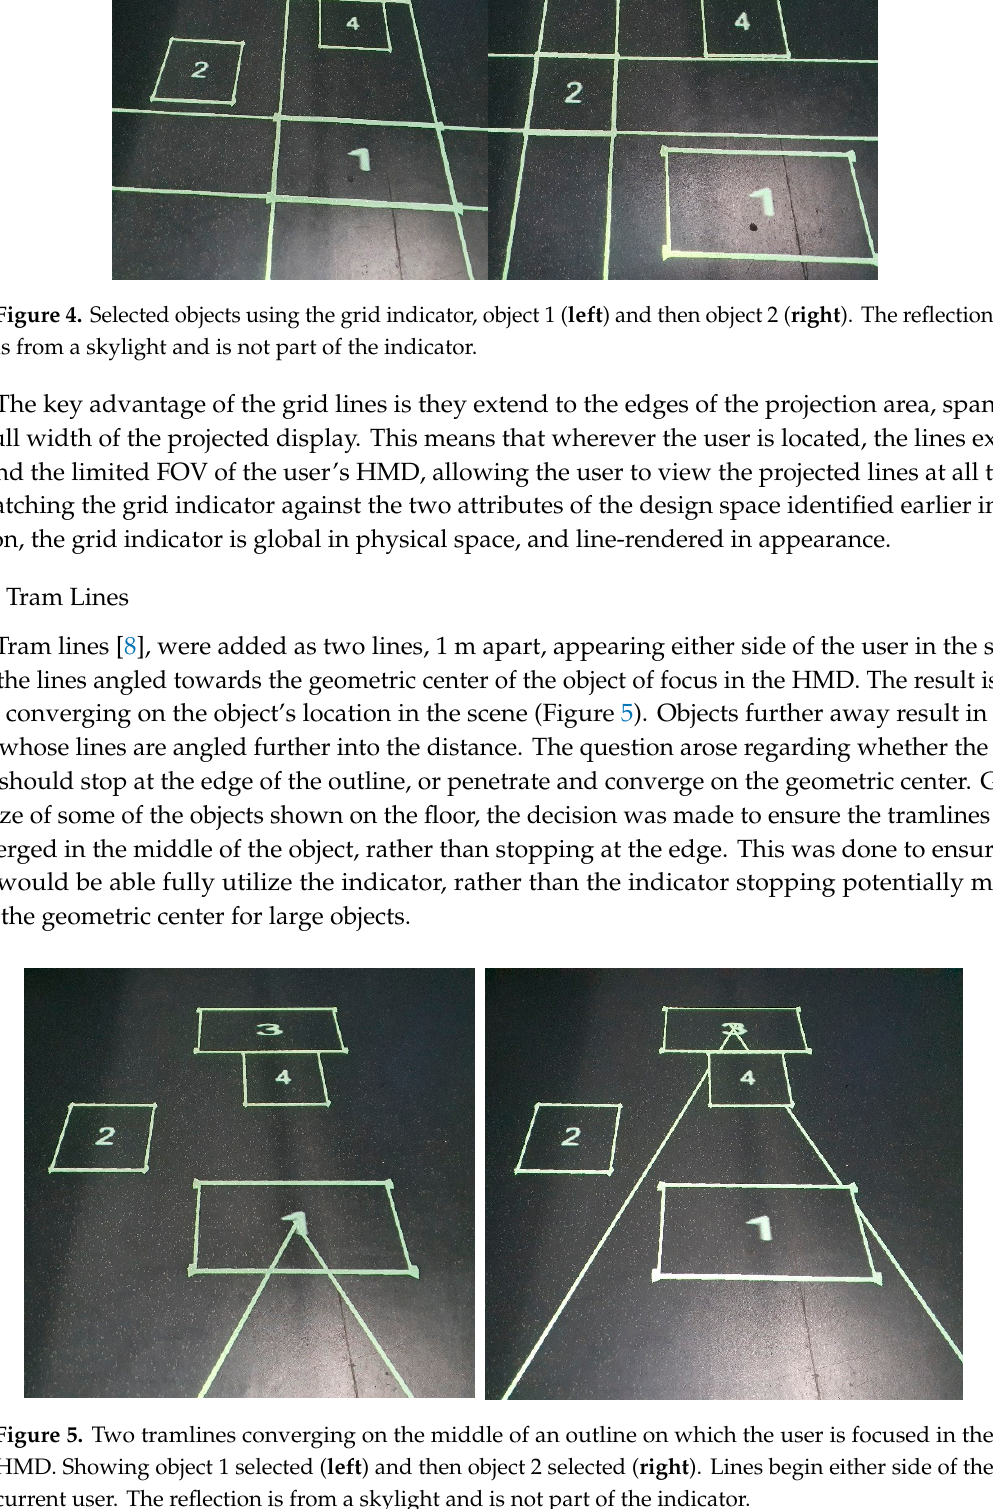
Figure 5. Two tramlines converging on the middle of an outline on which the user is focused in the HMD. Showing object 1 selected ( left ) and then object 2 selected ( right ). Lines begin either side of the current user. The reflection is from a skylight and is not part of the indicator.